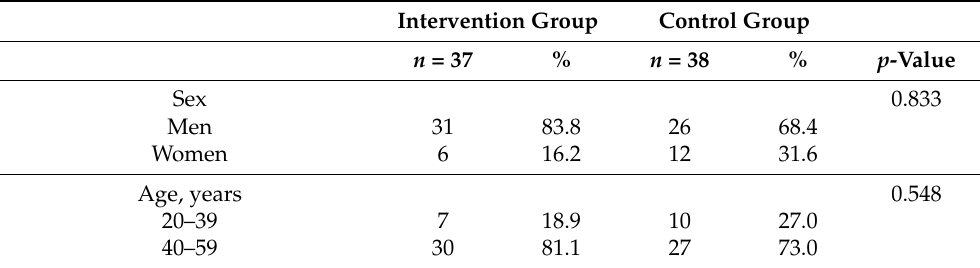
Table 1. Characteristics of the participants at